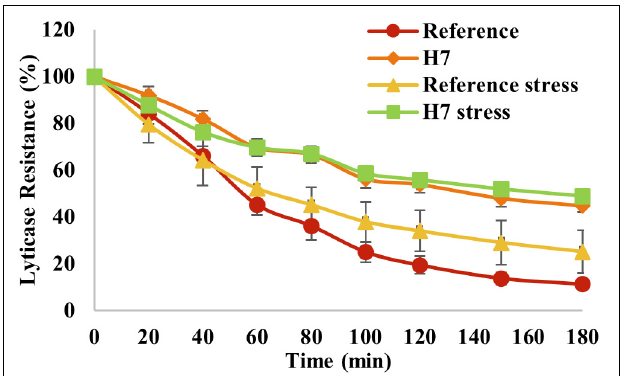
FIGURE 9 | Lyticase sensitivity assay results of the evolved strain H7 and the reference strain under oxidative stress (0.5-mM H 2 O 2 ) and control conditions. Lyticase sensitivity was calculated as the percent decrease in lyticase resistance from 100% as the initial value.